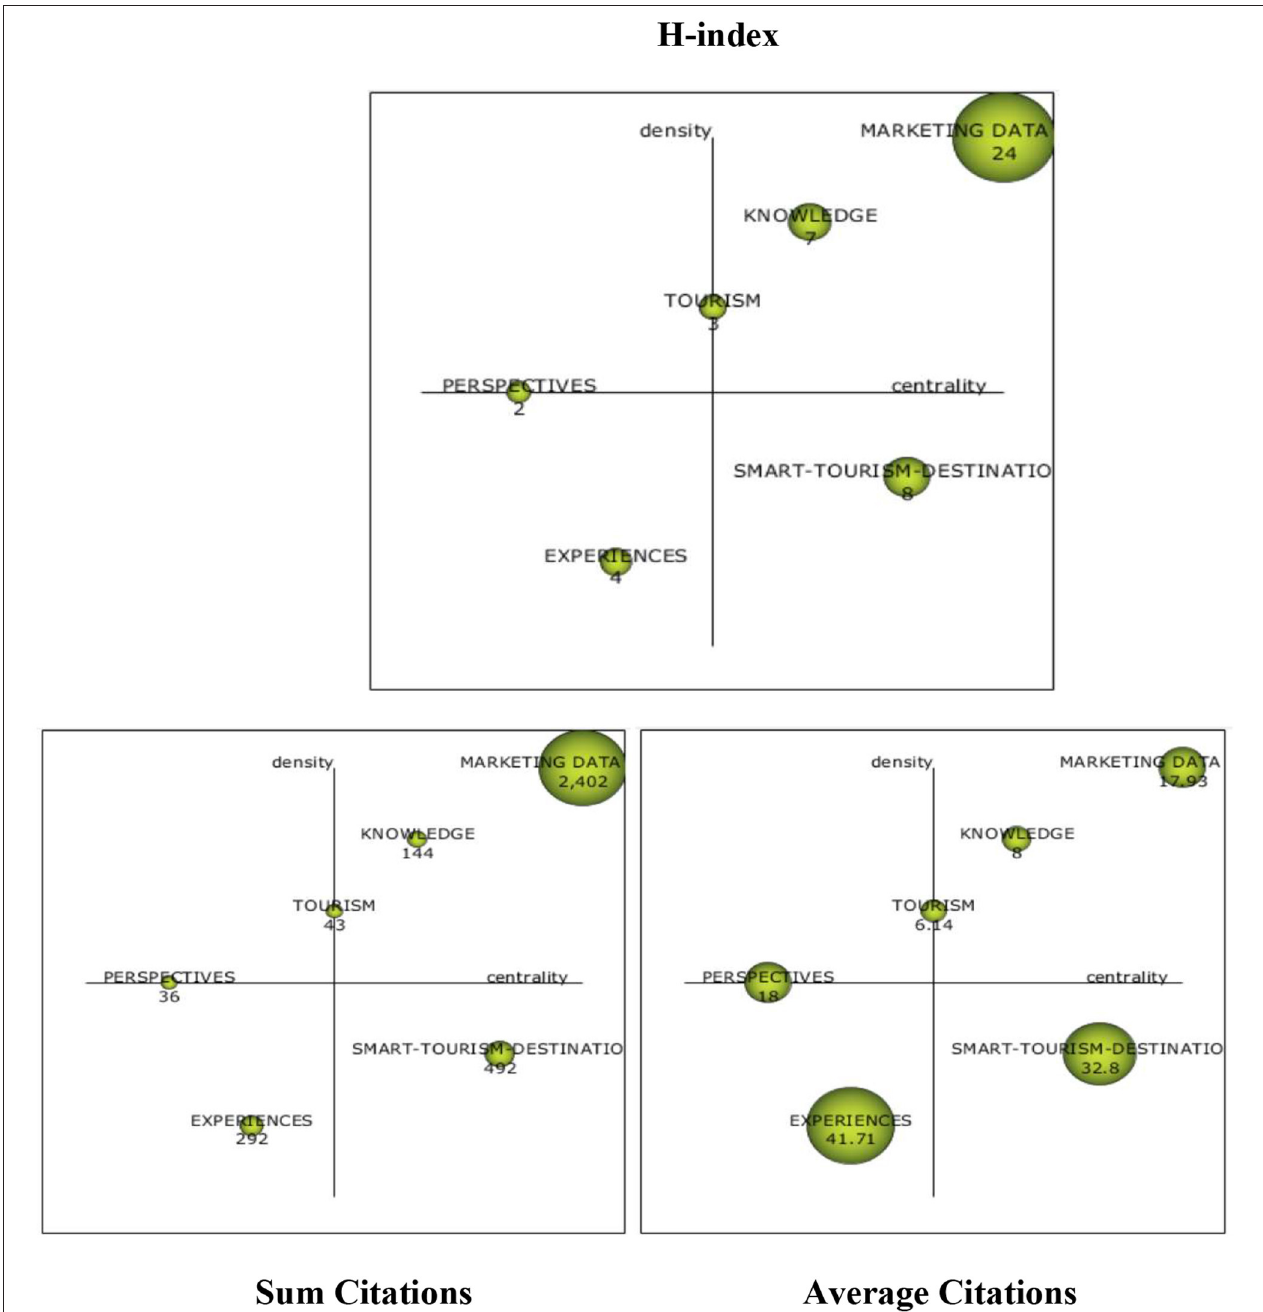
corresponds to internal associations of the concept with the keywords. On the other hand, the external cohesion index is obtained by combining all the equivalence indexes of its external